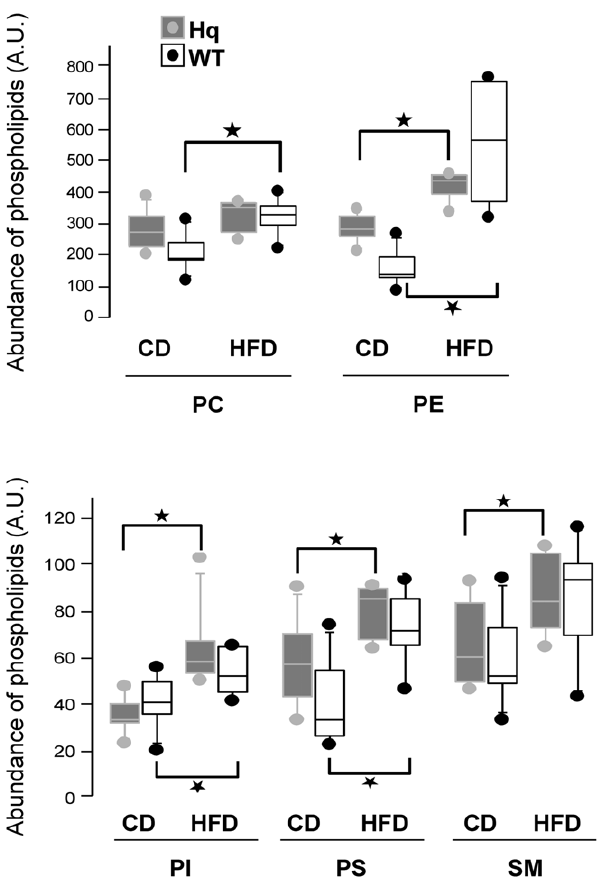
Figure 8. Box-and-whisker plot of different classes of phos- pholipids in cerebellum membranes. The abundance of various phospholipids is expressed in arbitrary units (A.U.) related to their internal standard and to the cerebellum dry weight (PC, phosphatidyl- choline; PE, phosphatidylethanolamine; PI, phosphatidylinositol; PS, phosphatidylserine; SM, sphingomyeline) in 7 WT and 7 Hq individuals. When compared to CD, HFD-fed individuals exhibit significantly higher levels of all the phospholipids in cerebellum except from PC in Hq and SM in WT which are not different between the 2 groups (CD and HFD). The vertical bars represent the range of values from the 10 th to the 90 th percentile; the boxes represent the values from the 25 th to the 75 th percentile; the horizontal lines represent the median value. Isolated circles represent all observations below the 10 th percentile or above the 90 th percentile. *: p , 0.05.